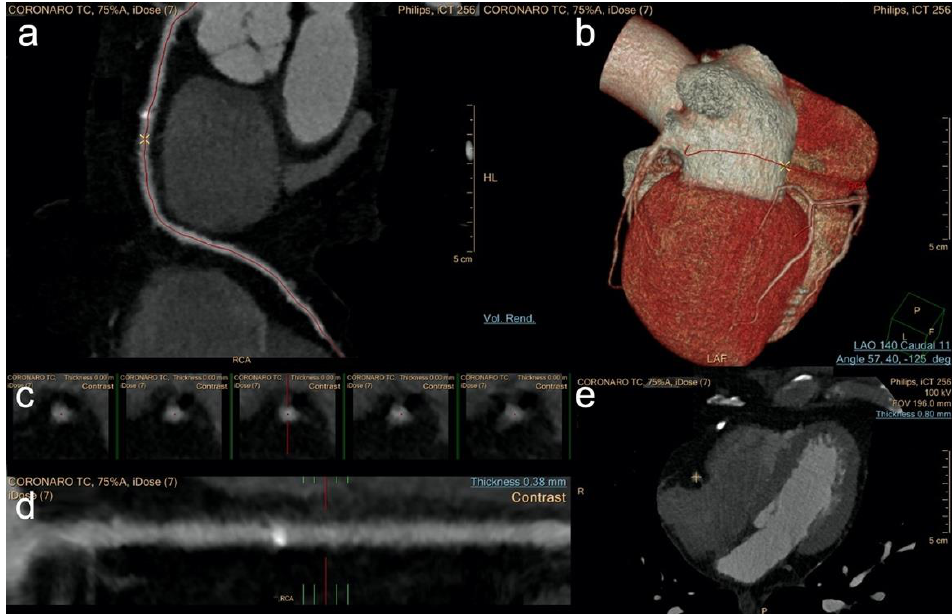
Figure 2. Software 2 showing cMPR of the RCA ( a ), a VR model of the whole heart ( b ), axial sections of the vessel lumen ( c ), a stretched cMPR along the centerline ( d ), and axial image of the middle segment of vessel ( e ).